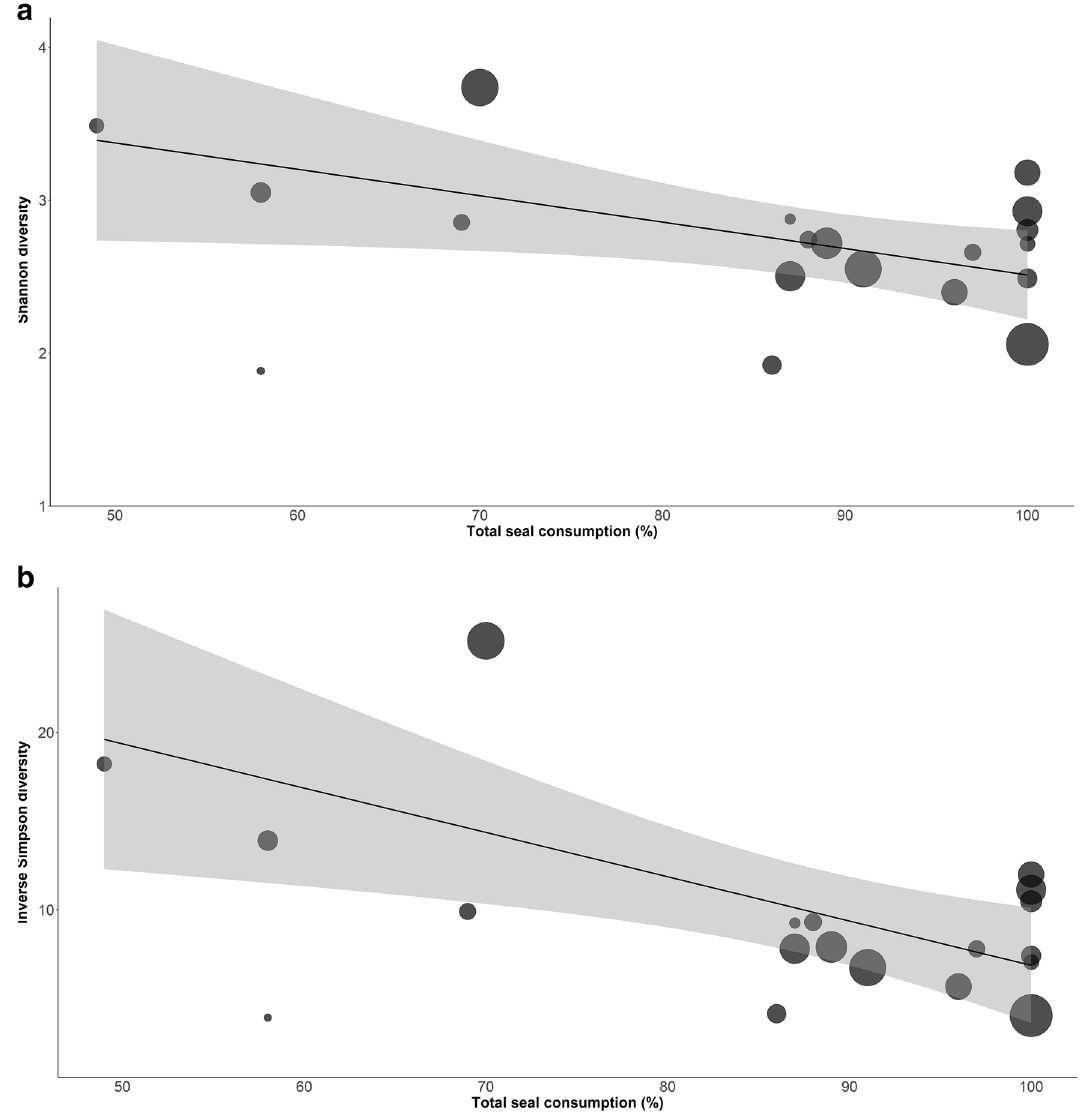
Figure 1. Associations between bacterial alpha diversity of the gut microbiota and percentage of seal consumed in the diet of Southern Beaufort Sea polar bears. Data points are weighted by hair total mercury concentrations measured for each individual, where a larger circle size reflects a higher mercury level detected within a given polar bear. The line of best fit takes in to account the weight of the data environments demonstrated a lower bacterial species richness in the gut 9 . However, our findings contrast with reports from laboratory mice and pregnant women, showing no significant difference in bacterial diversity was associated with heavy metal exposure (i.e. cadmium, lead or mercury 4,48,49 ). Our results also contrast findings in zebrafish ( Danio rerio ) experimentally exposed to lead, in which bacterial diversity instead significantly increased 47 . Therefore, in this study, our findings more closely mirror what is detected in natural conditions com- pared to a laboratory setting, perhaps indicating that experimentally derived results do not accurately reflect how contaminants impact the host microbiota in the wild. As previous studies have highlighted (see Pascoe et al. 50 ),